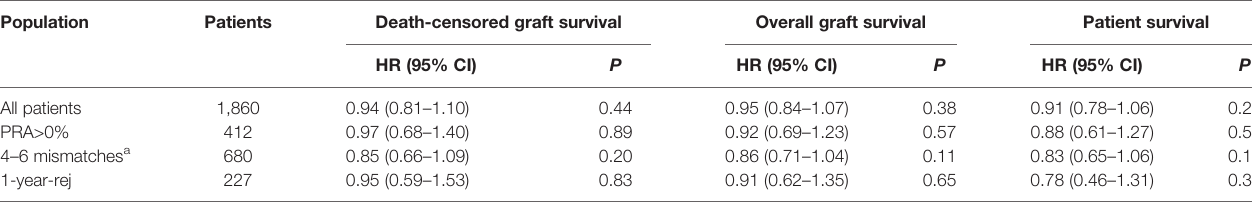
CTS, Collaborative Transplant Study; PRA, panel-reactive antibodies; rej, rejection treatment. a HLA-A+B+DR mismatch. Hazard ratios (HR) and 95% con fi dence interval (CI) per wild type allele are